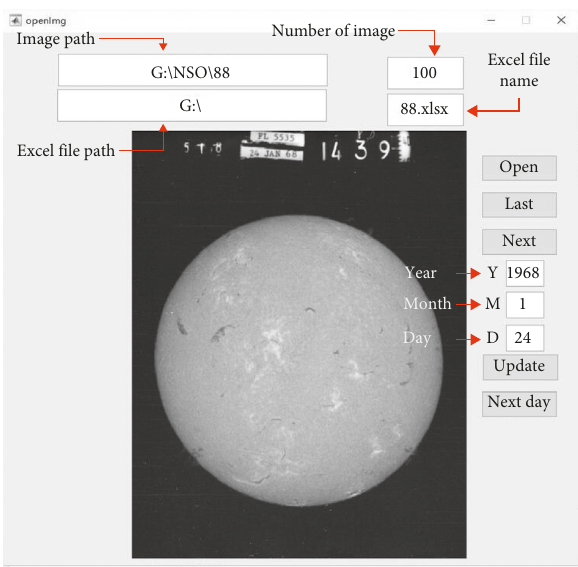
Figure 9: Graphic interface of date check. Table 3: Statistical table of recognition results.